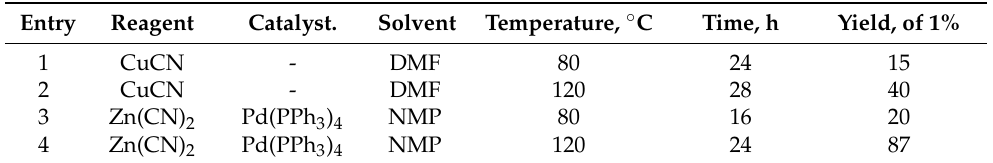
Table 1. Reaction of ( E )-4-(2-(7-bromobenzo[ c ][1,2,5]thiadiazol-4-yl)vinyl)- N , N -diphenylaniline 2 with metal cyanides.